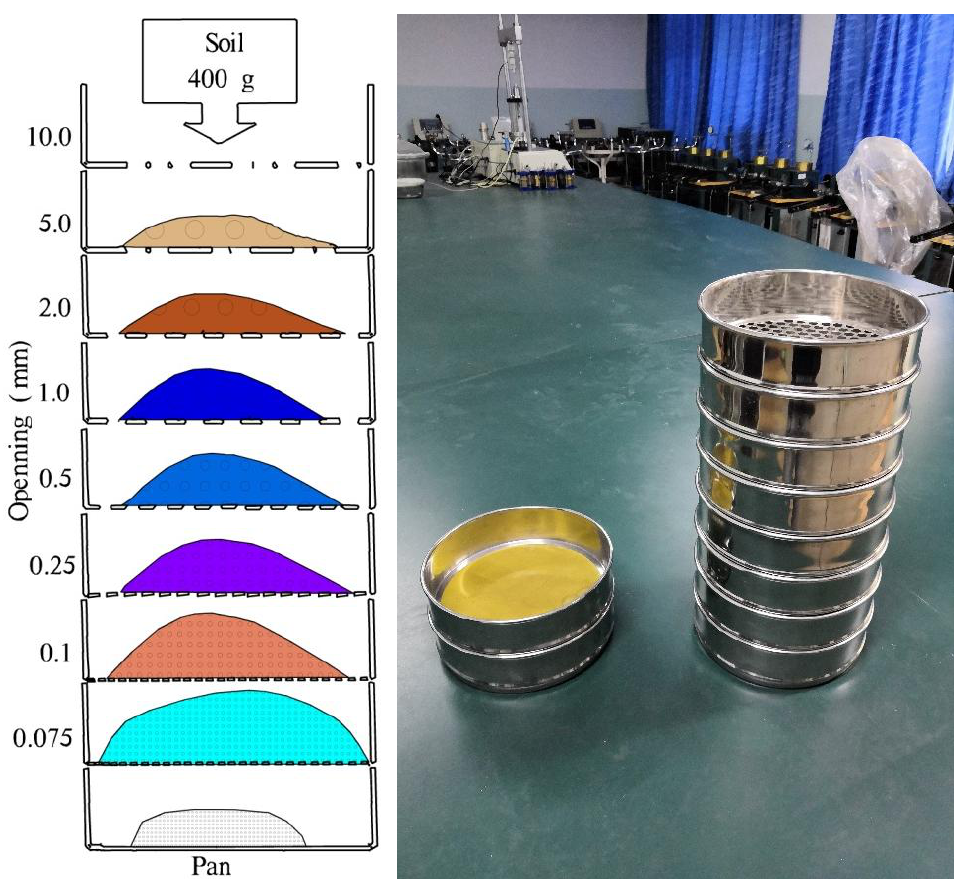
Figure 10. Sieving method.